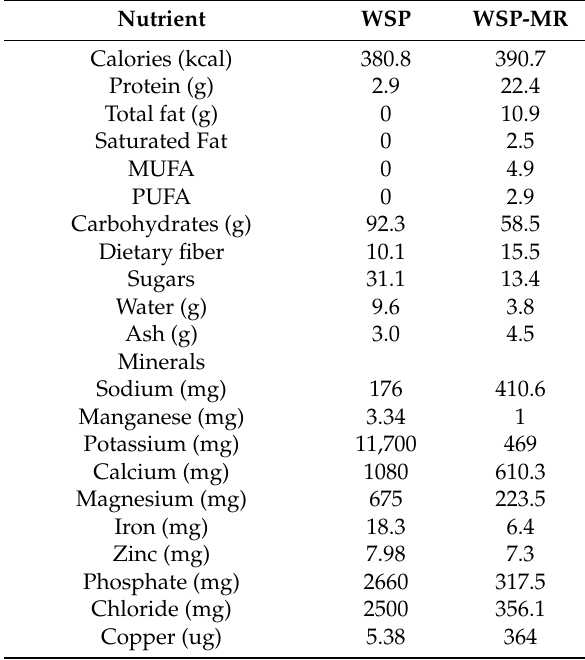
Table 1. Nutrient composition of white sweet potato and white sweet potato-meal replacement per 100